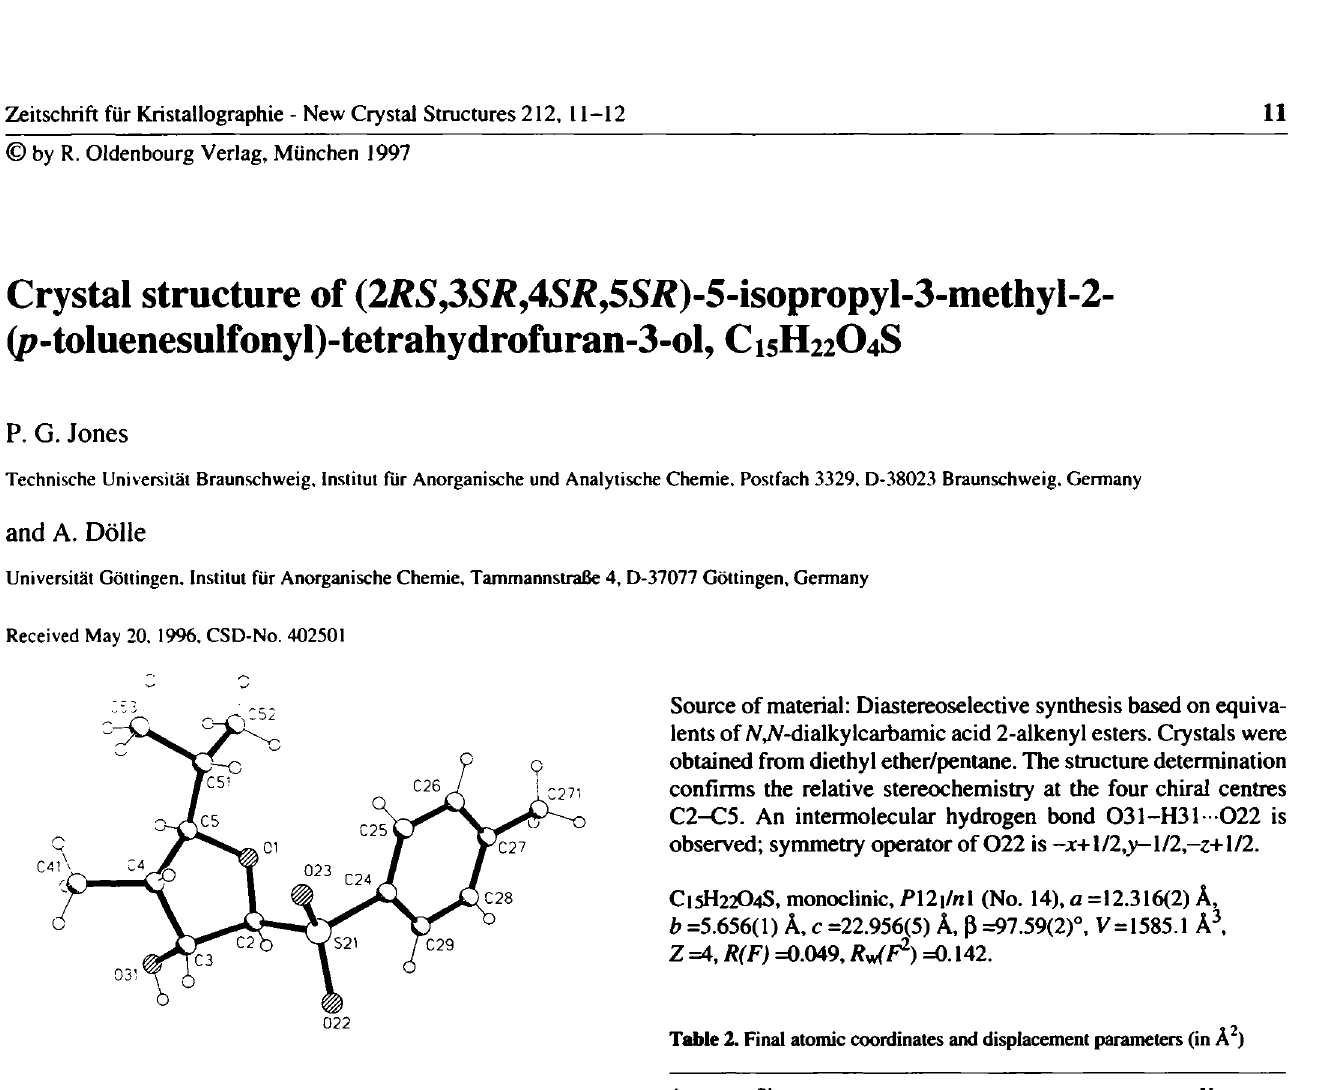
Table 2. Final atomic coordinates and displacement parameters (in A 2 ) Atom